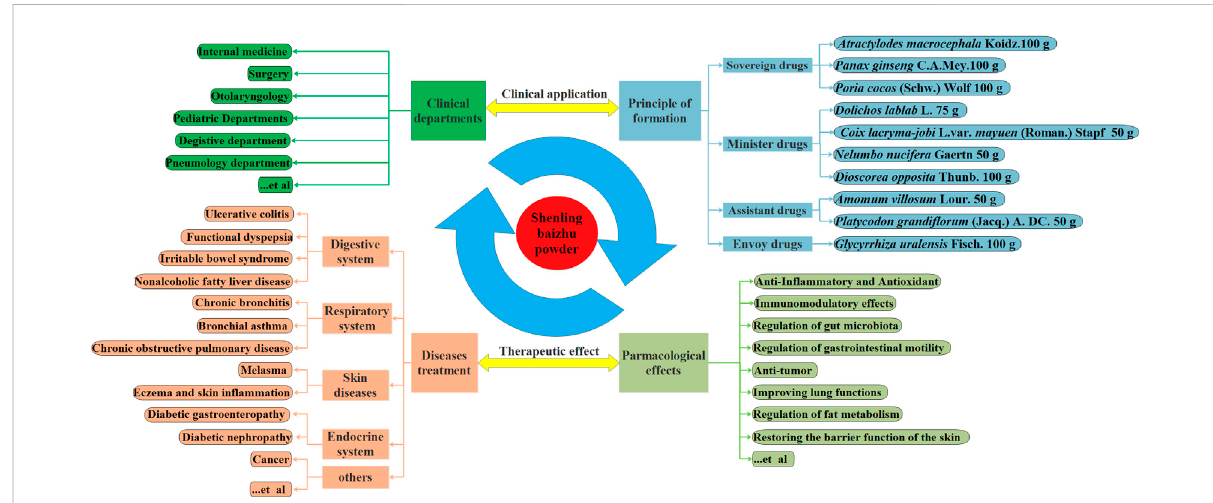
FIGURE 2 Composition of prescription, clinical applications and therapeutic effects of SLBZP.